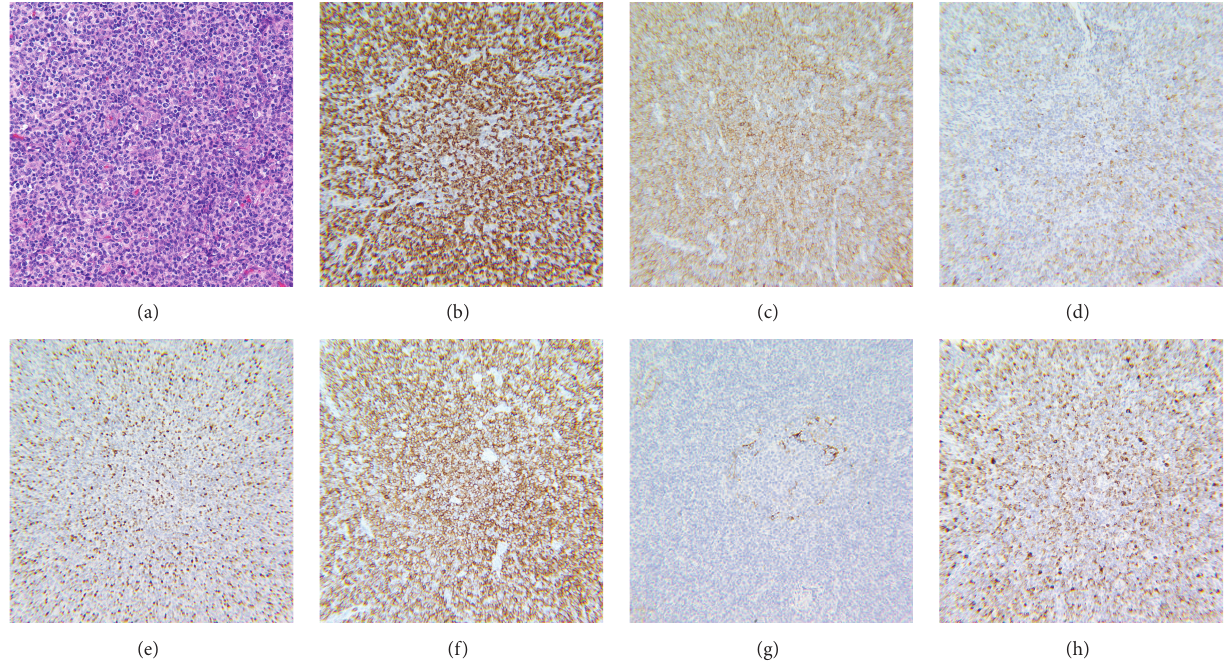
Figure 4: Composite: (a) H&E section of lymph node biopsy with an atypical infiltrate that is polymorphic with scattered large cells and prominent vascularity (40x). (b) Atypical lymph node cells showing immunoreactivity to CD3 (20x). (c) Atypical lymph node cells showing weak immunoreactivity to CD4 (20x). (d) Atypical lymph node cells showing partial immunoreactivity to CD10 (20x). (e) Atypical lymph node cells showing immunoreactivity to BCL-6 (20x). (f) Atypical lymph node cells showing immunoreactivity to CD5 (20x). (g) CD21 stain highlighting the follicular dendritic cells in a pattern consistent with angioimmunoblastic T cell lymphoma (20x). (h) Atypical lymph nodes cells showing immunoreactivity to perforin